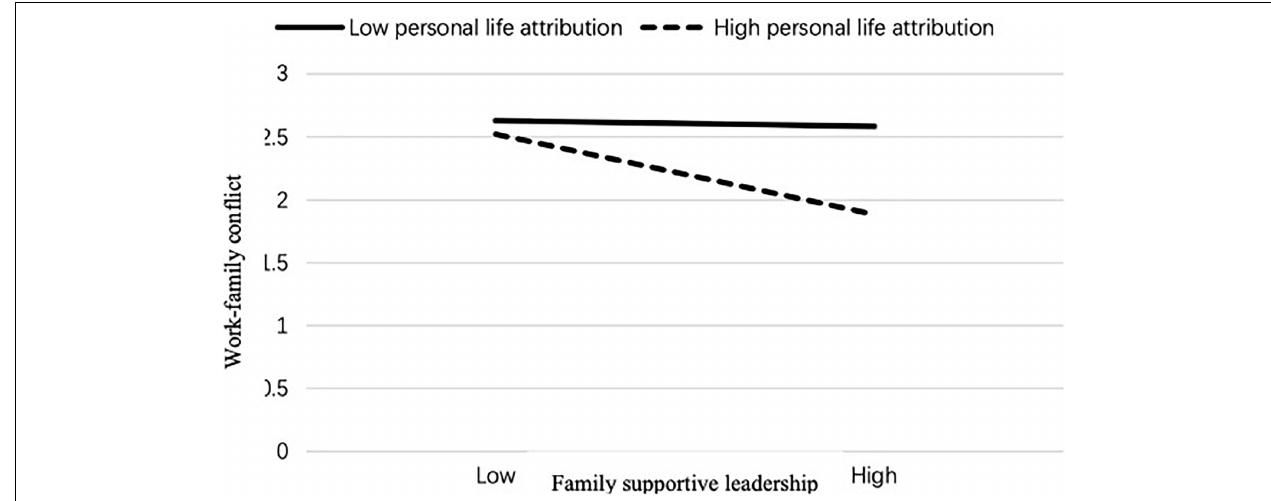
FIGURE 2 | Personal life attribution moderates the relationship between family supportive leadership and work-family conflict.